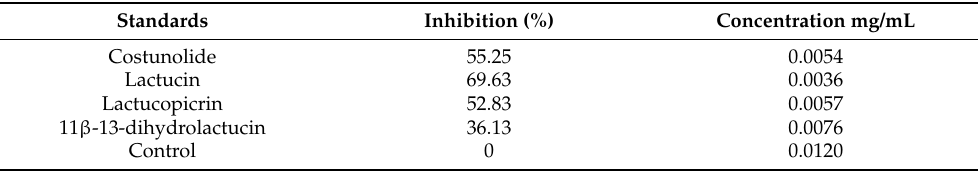
Table 6. Percentage inhibition of pyocyanin production in P. aeruginosa IBRS P001. The standard compounds were applied at 0.5 MIC. The concentrations of pyocyanin in the treated cultures (mg/mL) were compared to an untreated control to determine the percentage inhibition.